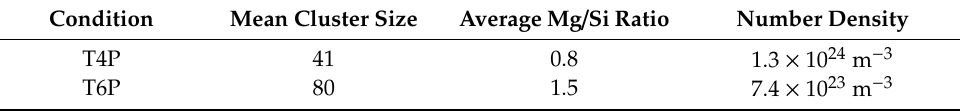
Figure 2 . APT analyses of Reference alloy visualizing the 3D atom maps of Mg–Si co-clusters ( a , b ) in T4P and T6P conditions. The corresponding cluster size distributions and proxigrams are shown in ( c – f ). The different circle diameters in ( c ) and ( d ) indicate the cluster size. Table 2. Properties of the Mg–Si clusters of Reference alloy in T4P and T6P conditions.